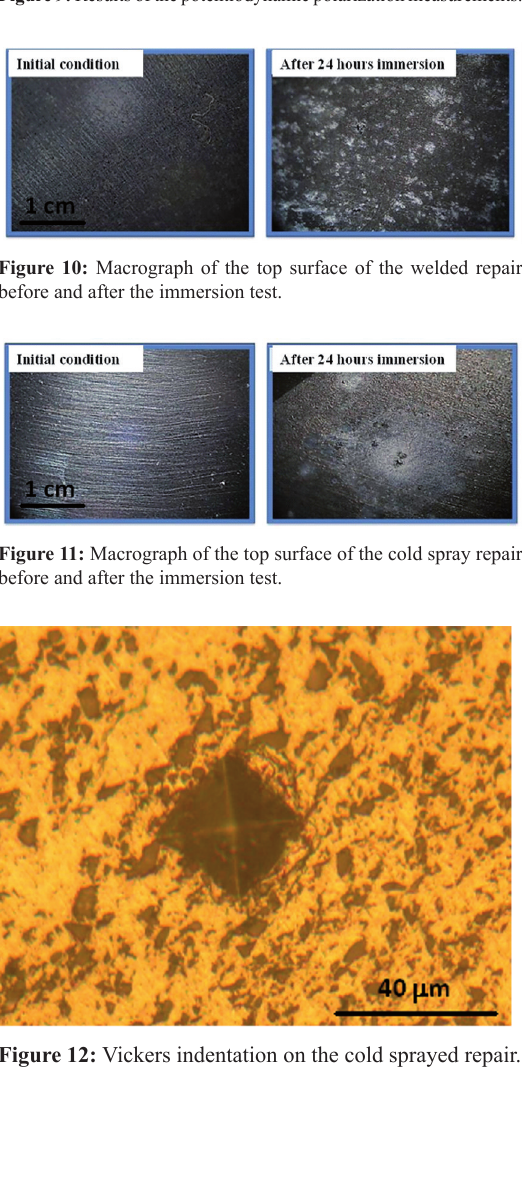
Figure 9: Results of the potentiodynamic polarization measurements.